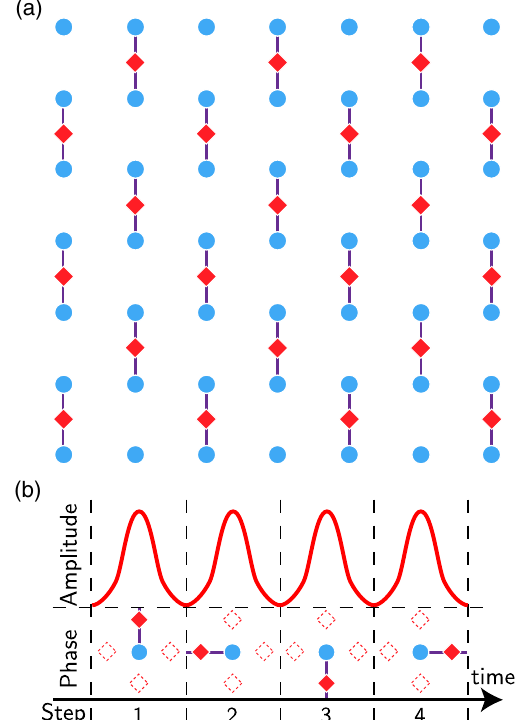
FIG. 6. Proposed optical lattice setup for realizing the bosonic MBL chiral Floquet phase using ultracold hard-core bosons. (a) We consider two square lattices, indicated, respectively, by blue circles and red diamonds, that are rotated by 45 degrees with respect to each other. We assume the blue lattice is deep and the system is strongly Mott insulating without the red lattice. The role of the red lattice is to offset the energy barrier between pairs of sites, thereby turning “ on ” the bonds between them, indicated by purple lines. (b) The red lattice is both amplitude and phase modulated, and sequentially turns on different sets of bonds in the first four steps of the Floquet